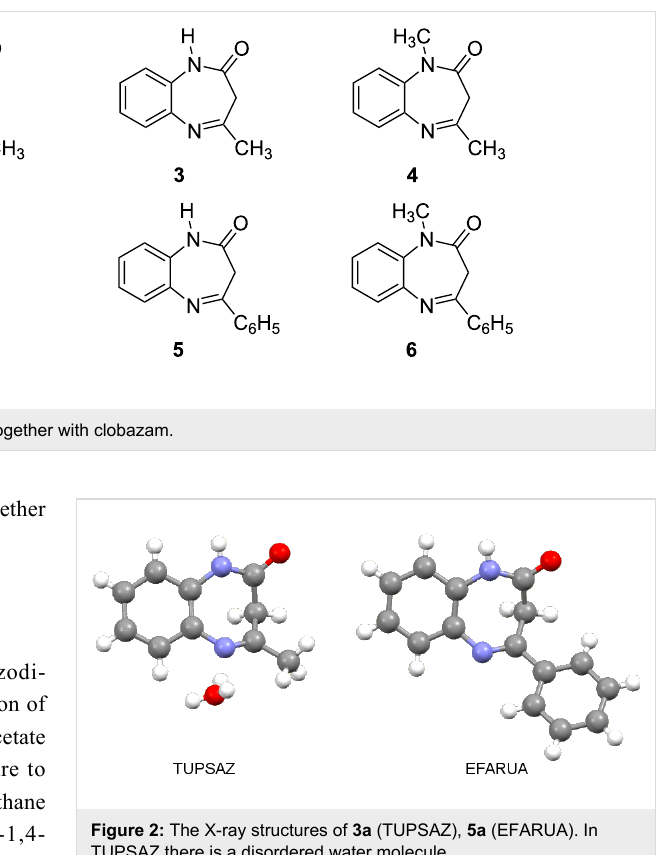
the aromatic ring and the nitrogen atoms. The dihedral angles between this plane and those formed by the C1N1O1 and N2C3C8 atoms are 35.4(2)º and 41.7(2)º, respectively. These molecules are linked forming dimers by symmetric hydrogen bonds between the amide group and the carbonyl oxygen atom of an adjacent one (distances N1H1···O1’ 1.932(2) Å and N1···O1’ 2.877(2) Å; angle NHO 162.7(1)º). These dimers interact by double intermolecular F–F contacts between the F5 of a molecule and the F6 of a neighboring one (distance 2.875(2) Å) giving rise to a zigzag chain in the [10-1] direction (Figure 4). These chains are stacked by a partial π – π overlapping between the aromatic rings with a shortest distance of 3.19(1)